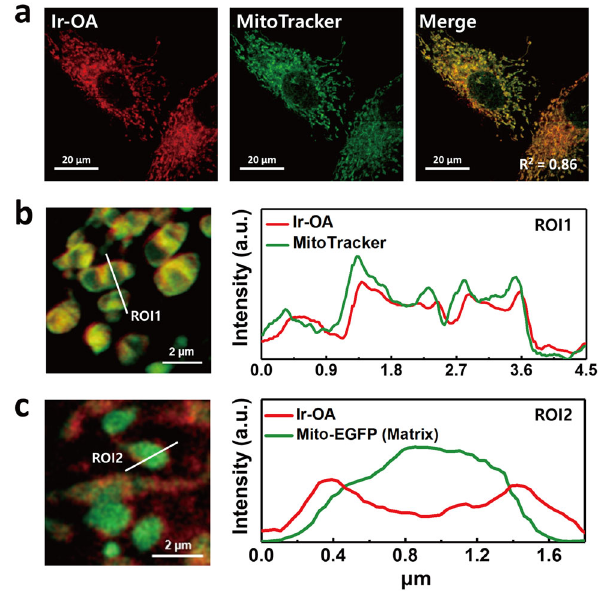
Fig. 2 Localisation of Ir-OA in living cells. a Confocal images of Ir-OA with MitoTracker. Phosphorescence of Ir-OA (red) and fl uorescence of MitoTracker (green) and merged image ( λ ex = 405 nm for Ir-OA, λ ex = 647 nm for MitoTracker ® Deep Red FM). Pearson ’ s coef fi cient was calculated using Image J software ( R 2 = 0.86). b Airyscan confocal image of mitochondria with Ir-OA (red) and MitoTracker (green, outer/inner mitochondria membrane) for identifying the speci fi c location of Ir-OA. c Airyscan confocal image of mitochondria with Ir-OA (red) and Mito-EGFP (green, mitochondrial matrix). Line pro fi ling for clarifying the speci fi c location of each emission signal was followed by corresponding images (right). The Ir-OA signal is well merged with the MitoTracker signal on the outer/inner mitochondrial membrane and encloses Mito-EGFP signal of the mitochondrial matrix. The mitochondria of Airyscan images were pre- swelled by photoactivation ( λ ex = 405 nm, 0.0125 mW) of the Ir-OA for identifying mitochondrial substructure (the mitochondrial swelling effect of the Ir-OA is explained later). Line pro fi ling analysis was proceeded with Carl Zeiss ZEN 3.0 Blue software. Conditions: [Ir-OA] = 4 μ M, [MitoTracker ® Deep Red] = 100 nM, incubation time = 2 h and 0.5 h, respectively. All imaging was repeated three times independently, and each experiment showed similar results. Source data are provided as a Source Data fi